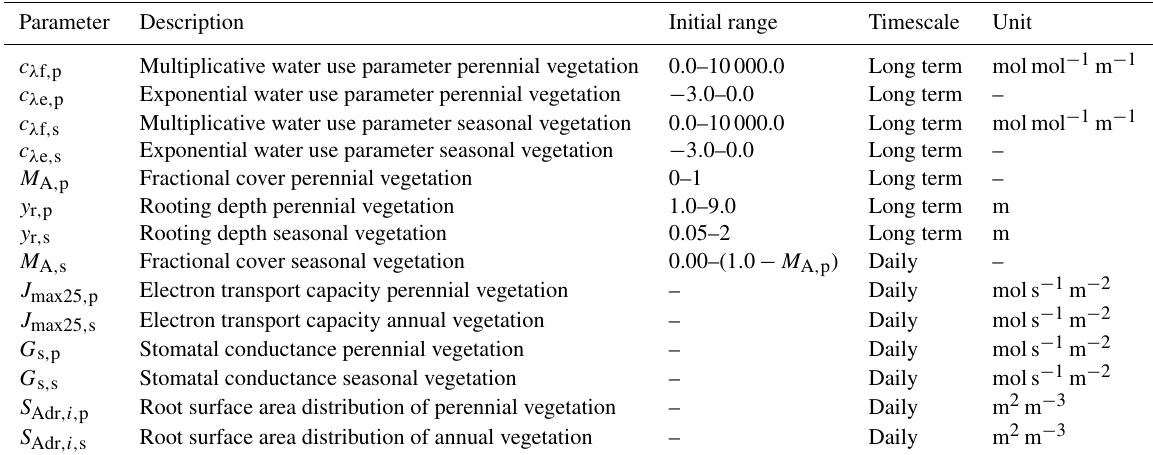
Table 3. Vegetation properties in the Vegetation Optimality Model optimized for maximizing the NCP.